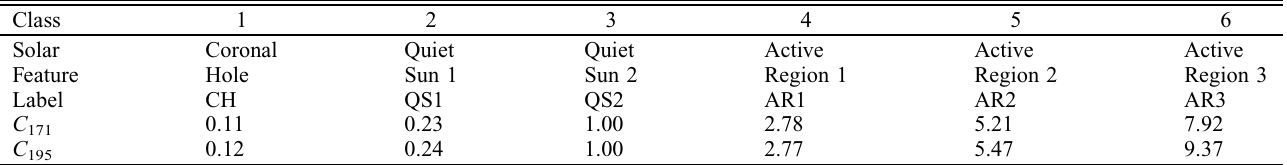
Table 1. Solar features employed in the spectral synthesis, listed increasing with